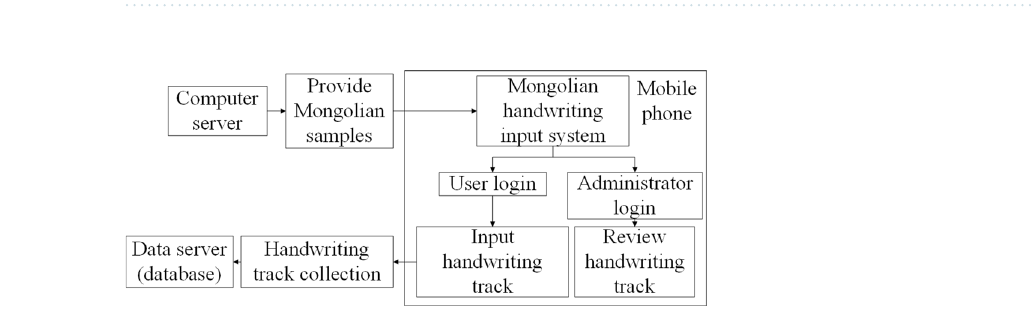
Figure 2. Word frequency statistics of different lengths.